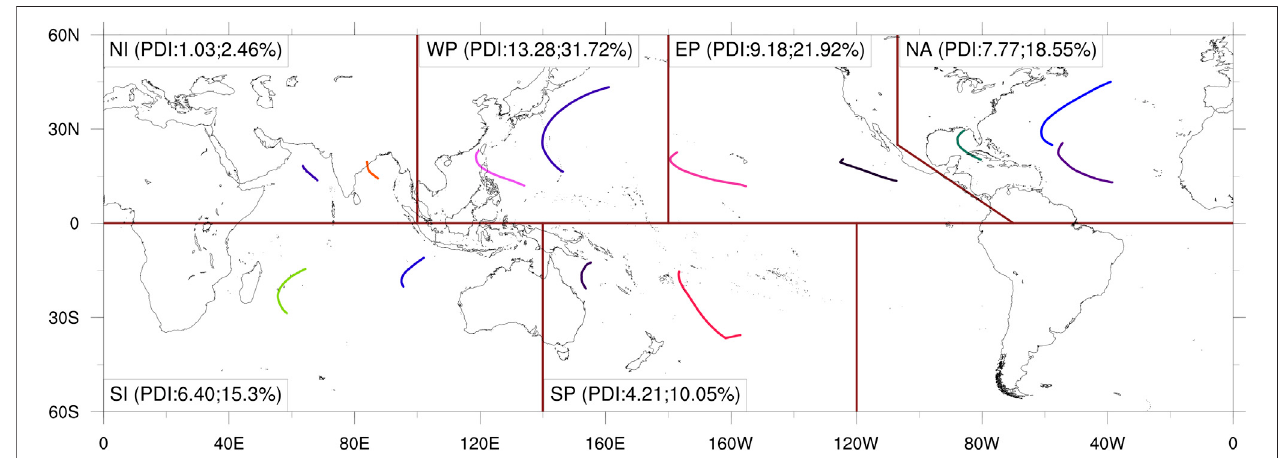
FIGURE 3 | Distributions of mean tracks for various TC track clusters in different regions based on IBTrACS best-track data. The deep red line indicates the divisionsofindividualareas,andthecolorcurvesindicatetheaveragetracksofTCsofdifferenttrackclusters.ThenumberinbracketsindicatesthePDIvalueinaspeci fi c area (units: 1013 m 3 s − 2 ) and its ratio to global total PDI.